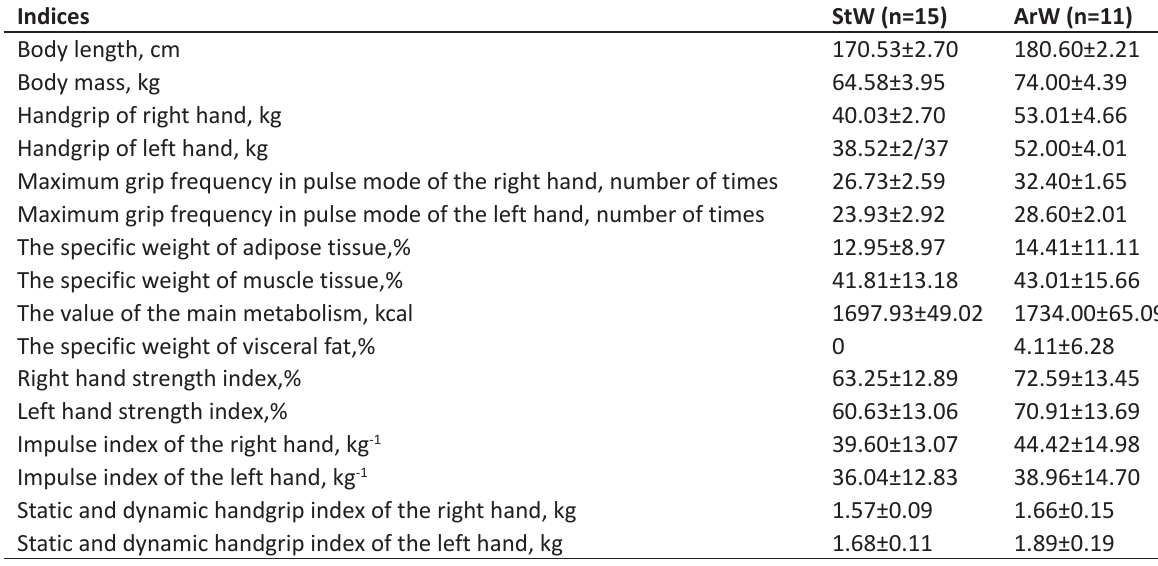
Table 1. Indicators of physical and somatotype development of armwrestling athletes and street workout athletes